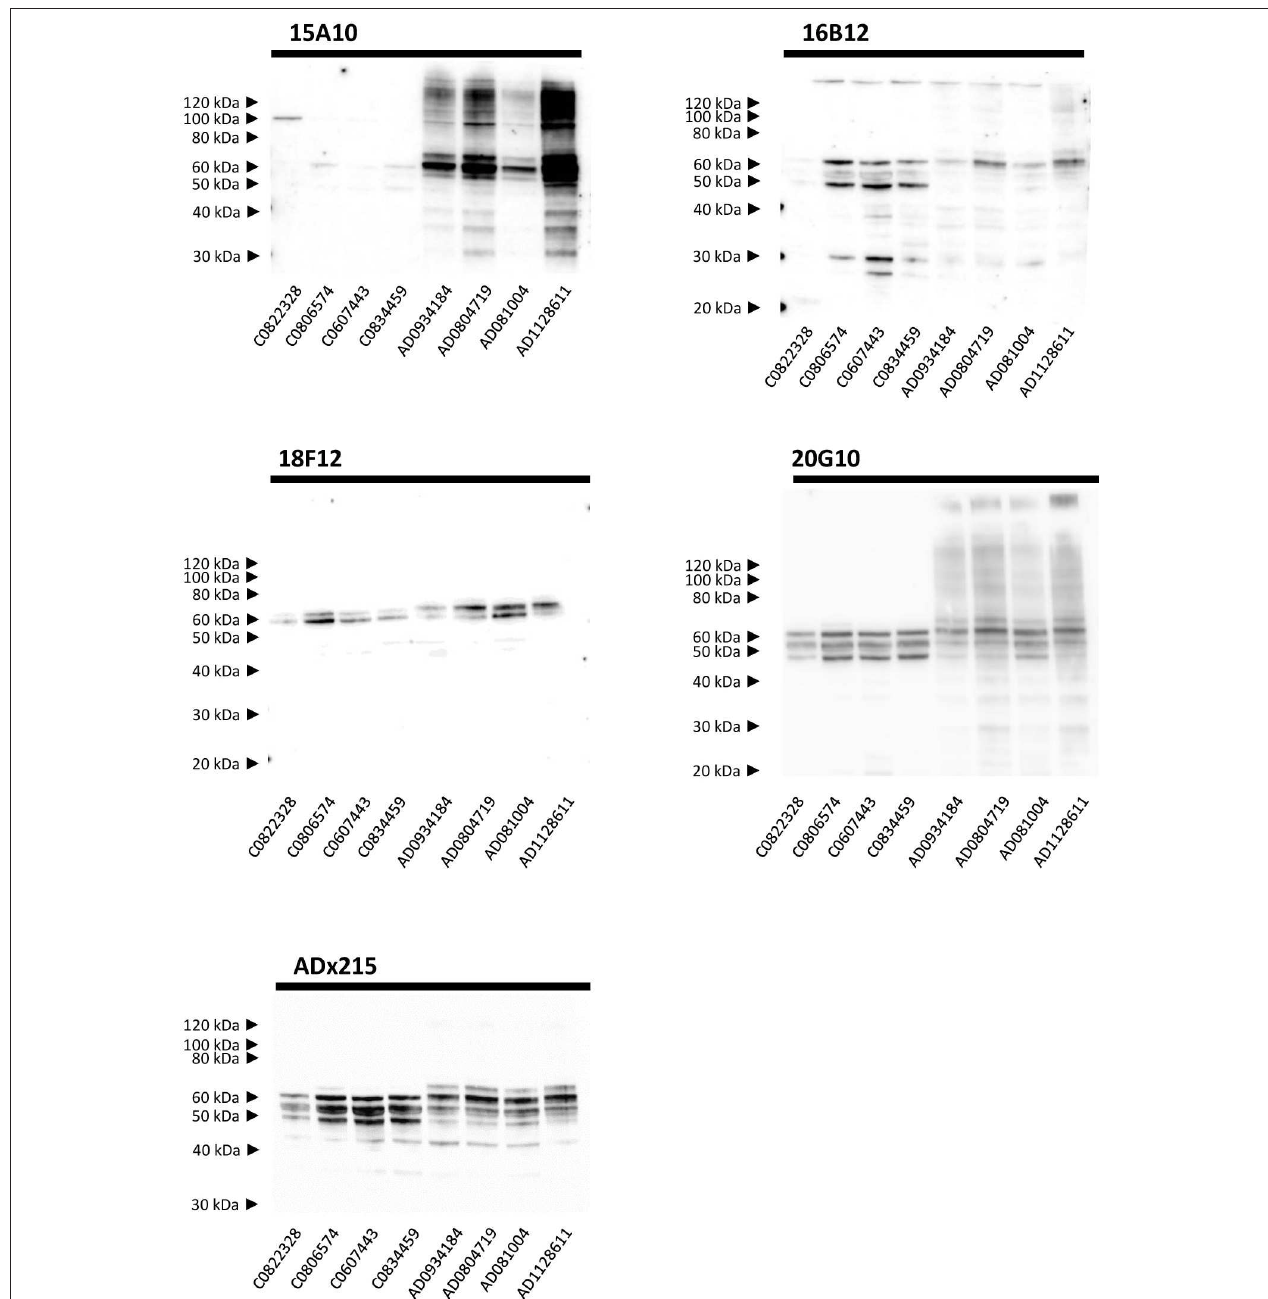
FIGURE 5 | Biochemical validation in human brain extracts. Western blot analysis of homogenates of human frontal cortex. Lane 1–4, brain extracts from healthy controls (C numbers), lane 5–8 brain extracts from AD patients (AD numbers) at Braak stage 5.